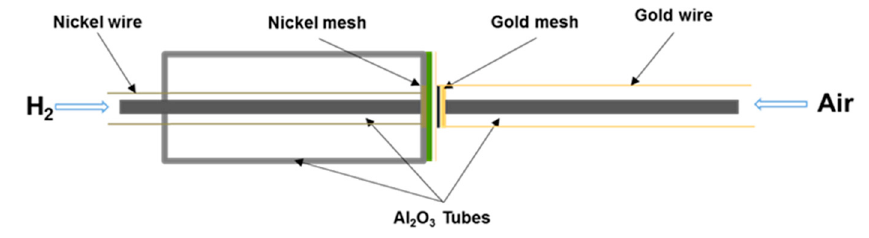
Figure 3. Schematic of the setup used for electrochemical measurements.